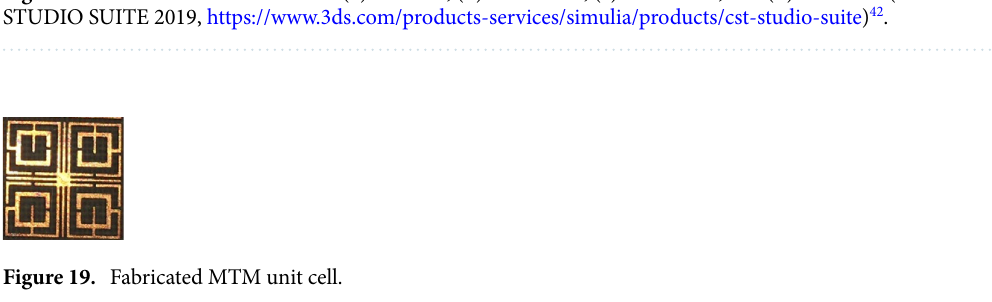
Figure 19. Fabricated MTM unit